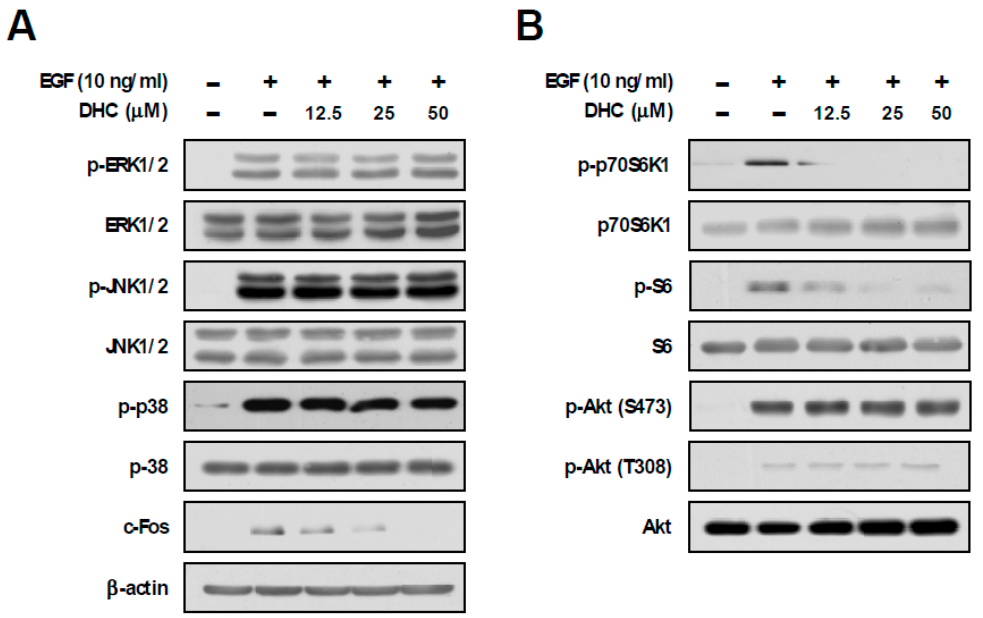
Figure 2. E ff ect of dihydrocapsaicin on EGF-induced MAPKs and mTOR pathway. ( A , B ) JB6 P + cells Figure 2. Effect of dihydrocapsaicin on EGF-induced MAPKs and mTOR pathway. ( A, B ) JB6 P+ were starved using 0.1% FBS-MEM for 24 h and then treated with dihydrocapsaicin 1 h prior to EGF cells were starved using 0.1% FBS-MEM for 24 hours and then treated with dihydrocapsaicin 1 hour (10 ng / mL) treatment. Cells were collected 15 min after EGF (10 ng / mL) treatment, and immunoblot prior to EGF (10 ng/ml) treatment. Cells were collected 15 min after EGF (10 ng/ml) treatment, and analysis was performed using the corresponding immunoblot analysis was performed using the corresponding antibody.